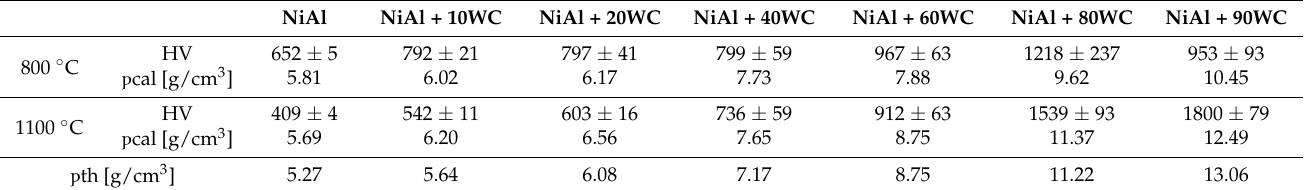
Table 6. Vickers hardness (HV), calculated density ( (cid:223) cal) and theoretical density ( (cid:223) th) of sinters.